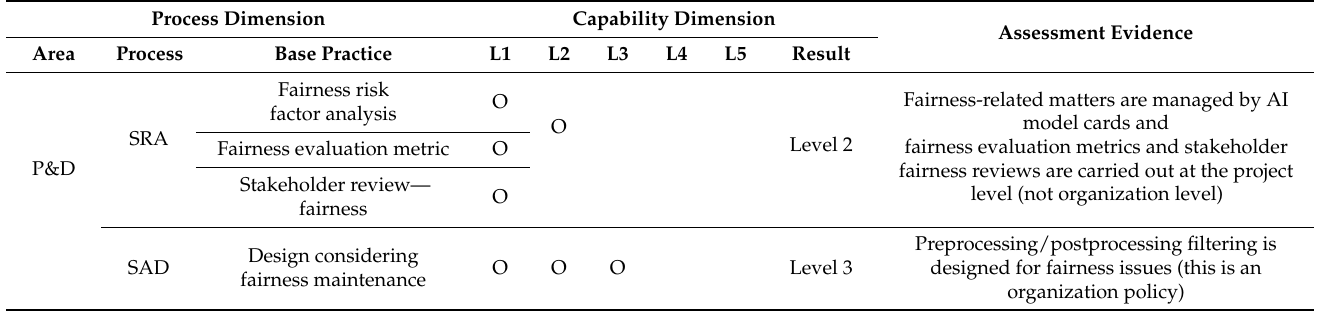
Table 13. Assessment results of language translation by AI-FMM